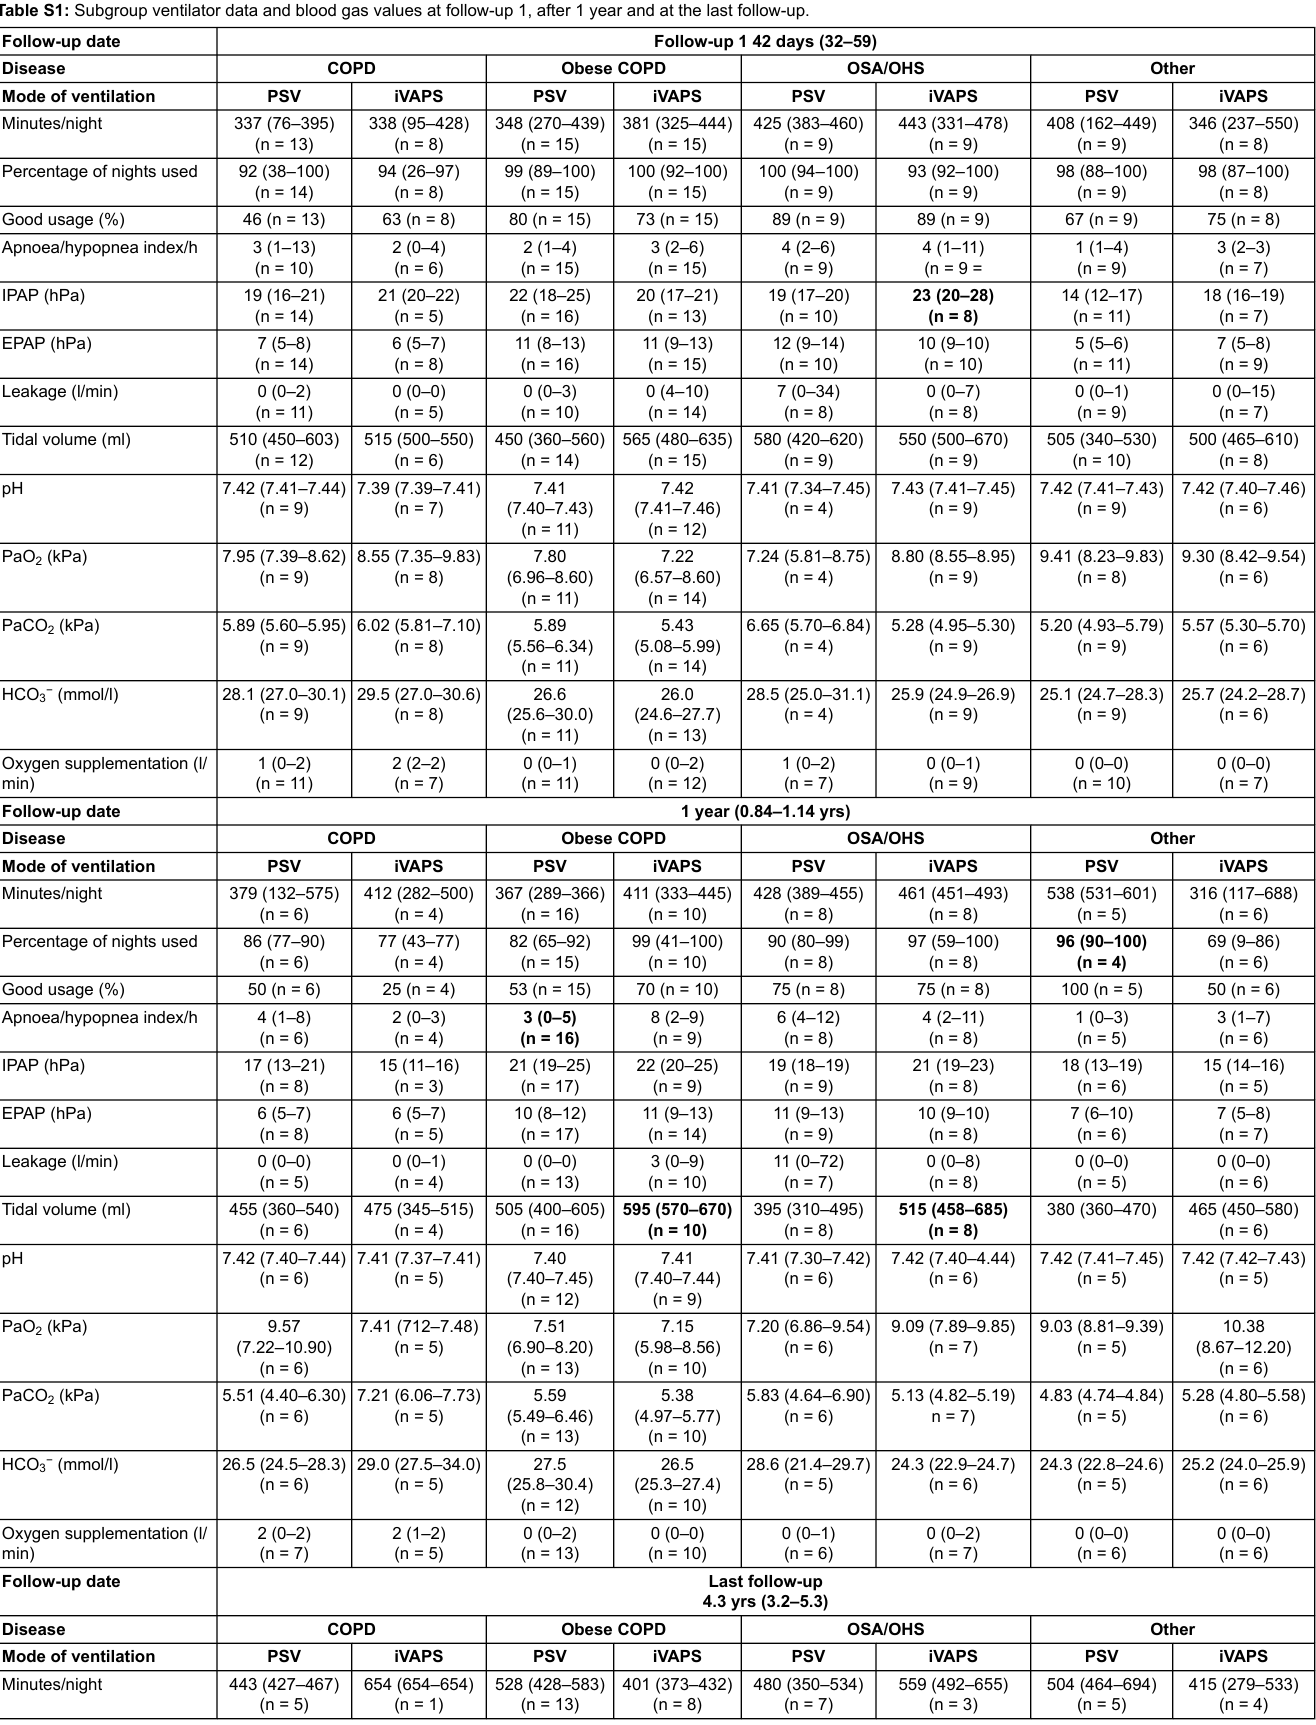
Table S1: Subgroup ventilator data and blood gas values at follow-up 1, after 1 year and at the last